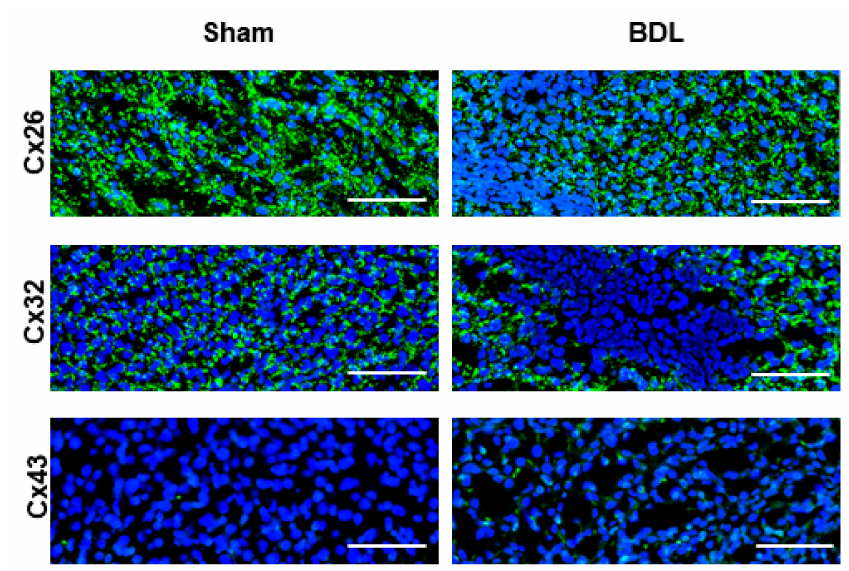
Figure 5. Connexin protein localization in livers of cholestatic mice. Liver sections were obtained from male mice following bile duct ligation (BDL) for 20 days. Cellular localization of Cx26, Cx32 and Cx43 (green) was revealed by immunohistochemistry analysis with nuclear counterstaining using DAPI (blue). Scale bar, 100 µ m (Sham n = 3; BDL n = 3) (N = 1).